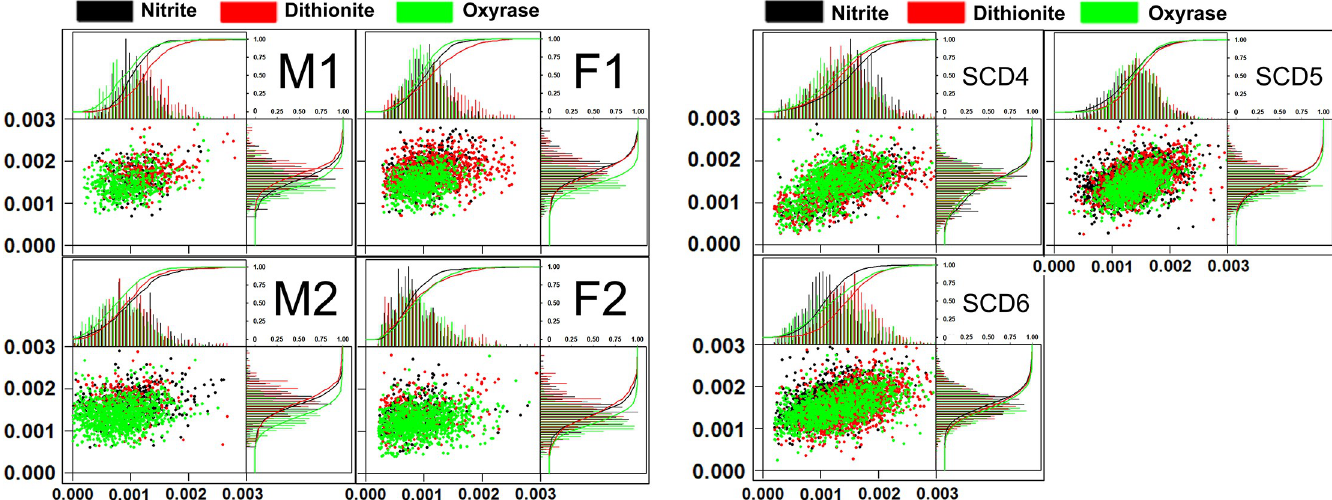
Fig 4. A. CTV data for two healthy male and two healthy female donor RBCs. Scatter plots with offset histograms and cumulative curves for the u m (x-axis) and u s (y- axis) for RBCs from four healthy donors that are treated with sodium nitrite (black), sodium dithionite (red) and Oxyrase (green). B. CTV data for three SCD donor RBCs of unknown gender. Scatter plots and histograms comparing three paramagnetic preparation methods on RBCs from three SCD patients of unknown gender are shown.